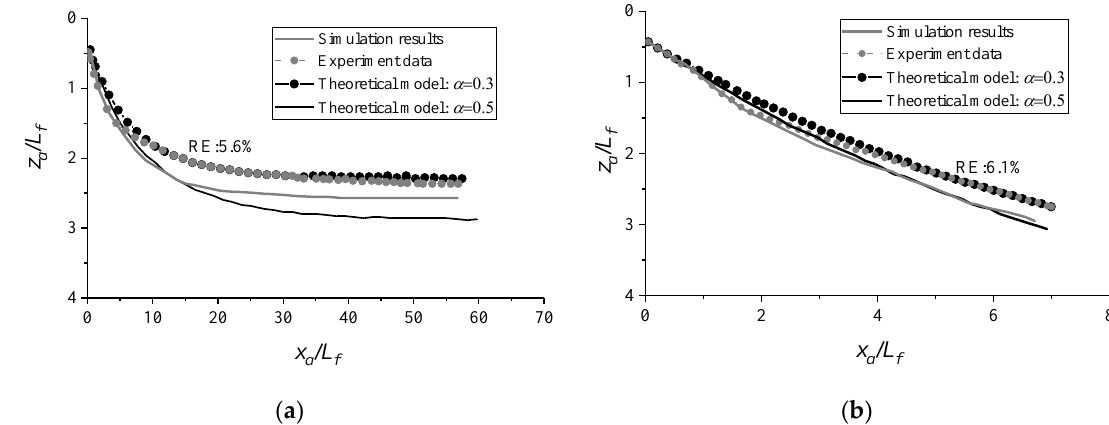
Figure 11. Comparative results of centrifuge tests conducted by O’Neill and Randolph [16,47]: ( a ) θ s = 32 ◦ ; ( b ) θ s = 50 ◦ .